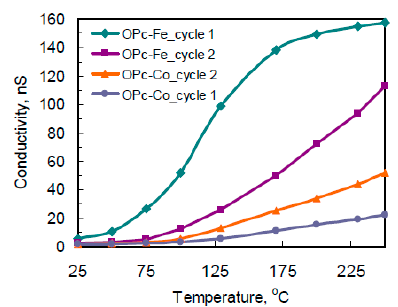
Figure 2. Typical conductivity dependence on temperature for OPc-Co and OPc-Fe films at two serial cycles.